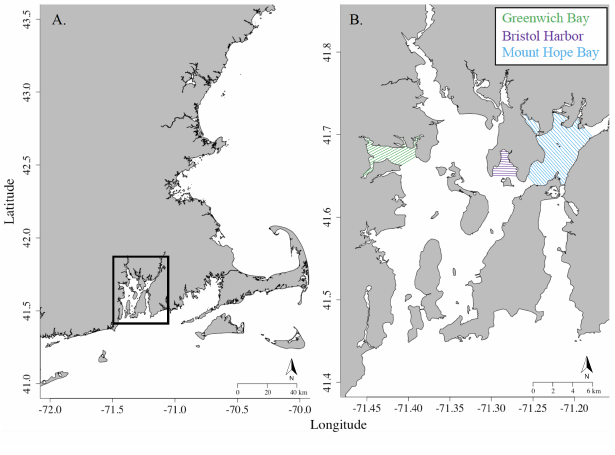
Fig. 2 . (A) The location of Narragansett Bay, RI relative to the Northeast United States and (B) the distribution of forage fish commercial fishing in Narragansett